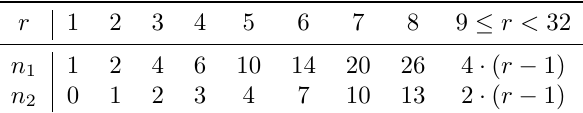
Table 1: The minimum number of active S-boxes in differential and linear activity patterns in up to 32 rounds of CRAFT . n 1 and n 2 denote the numbers for original and weak tweak-key CRAFT ,